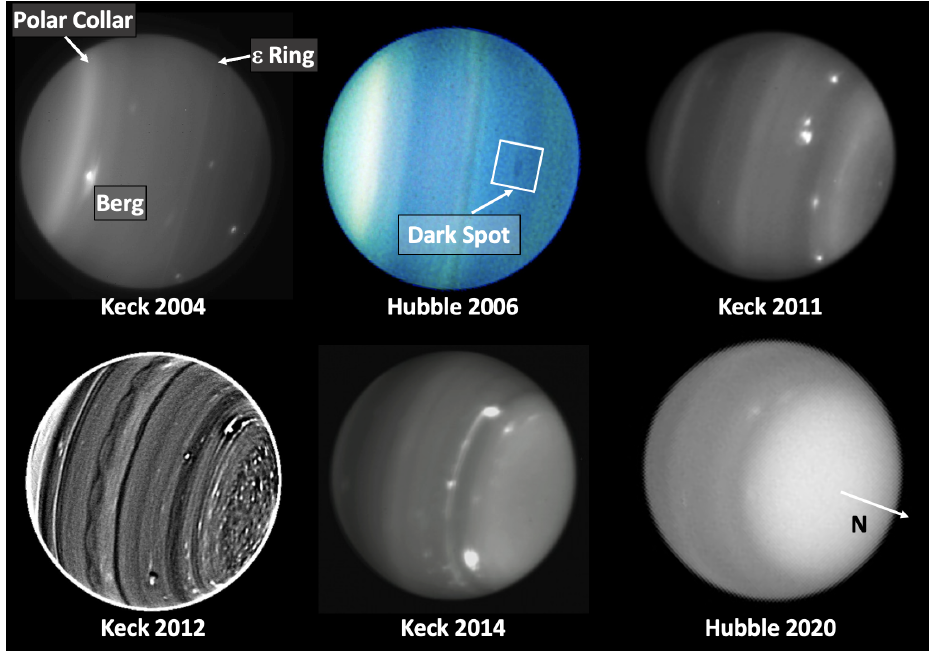
Figure 9. Uranus’s cloud features in Hubble ACS and WFC3 and Keck H-band images from 2004 to 2020 [24,25,69,111–113]. The Hubble ACS color composite in 2006 uses 755, 658, 550 nm in the R, G, B channels, respectively, and in 2020 the WFC3 845 nm filter is shown [111]. The 2012 Keck image is a high signal-to-noise, de-rotated, average image, high-pass filtered to show low-contrast cloud details [24]. Bright clouds are prominent in the H-band images and the south polar region has faded while the north polar region has brightened with the changing Uranian